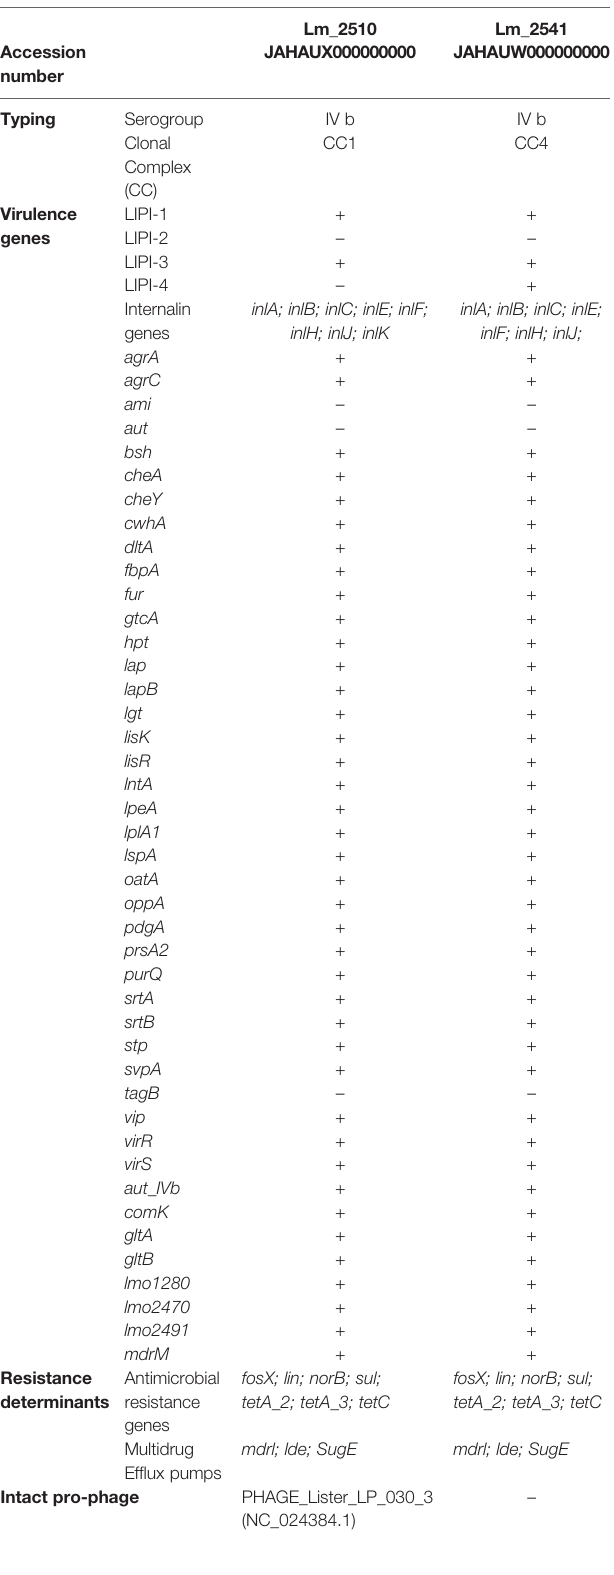
TABLE 1 | Whole Genome Sequencing analysis of the Lm isolates: for each strain serogroup, clonal complex, accession number, presence/absence of virulence genes, resistance determinants and intact pro-phage are